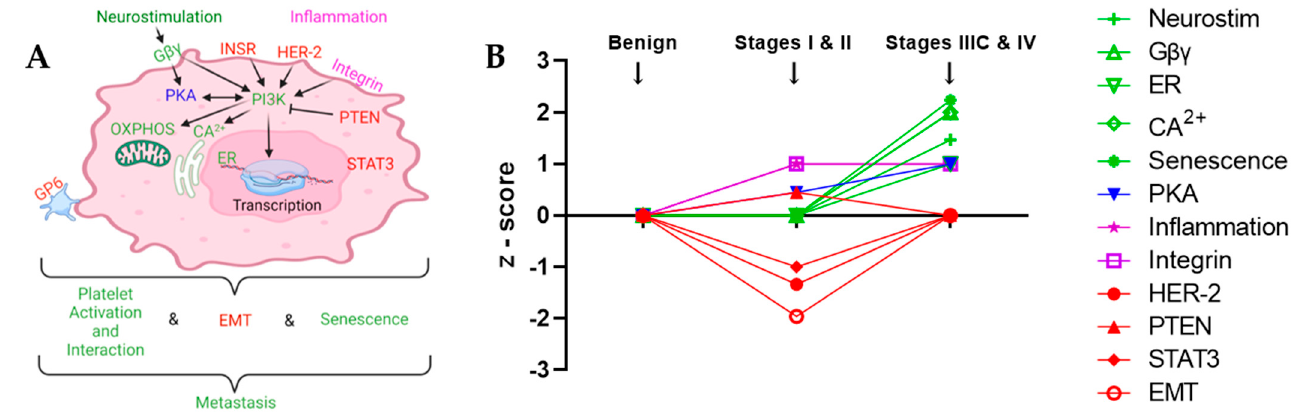
Figure 4. Evolution of canonical pathways in progression from Benign to Early Endometrial Cancer Stages I and II to Metastatic Endometrial Cancer Stages IIIC and IV. ( A ) Illustration of the cellular context of pathway components implicated in endometrial cancer metastases. ( B ) The z-scores for the association of the differential sera proteins in the individual pathways plotted for the different groups. Positive z-scores indicate activation, negative z-scores indicate repression of the pathways. EMT/Fibrosis is the average of hepatic fibrosis signaling, regulation of EMT by growth factors, GP6 signaling and regulation of EMT in development pathways in the Stages I and II group. Neurostim- ulation (Neurostim) represents the average of cardiac hypertrophy signaling, synaptic long-term depression, role of nfat in cardiac hypertrophy, endocannabinoid neuronal synapse and synaptogene- sis signaling in the stages IIIC and IV group. Inflammation refers to Th2 signaling in the stages I and II group and PI3K signaling in B lymphocytes in stages IIIC and IV. ( A , B ) In both panels, red indicates loss of pathway regulation is associated with metastatic progression; purple indicates activation of pathway occurs in early endometrial cancer; blue indicates progressively increased activation with metastatic progression; green indicates that pathway regulation is associated with metastatic progression. Subfigure ( A ) created with